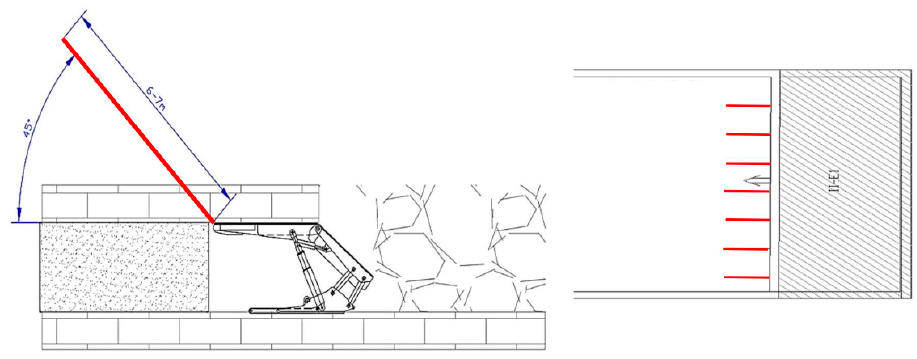
Figure 3. Directional hydraulic fracturing scheme within longwall II-E1 at coal seam 713/1-2. From July 9, 2017 until November 19, 2017 DHF was used 20 times, while the number of holes used for hydraulic fracturing was fluctuating between 3–7, and each time was depending on roof conditions present within the longwall and the proceeding collapse.